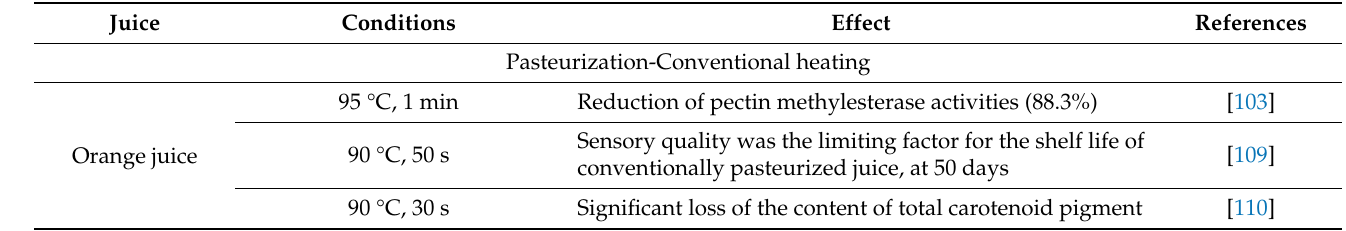
Table 2. Thermal and non-thermal processing technologies of fruit